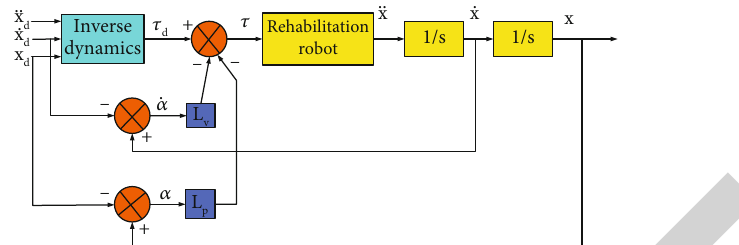
Figure 5: Feedforward + PD feedback control.